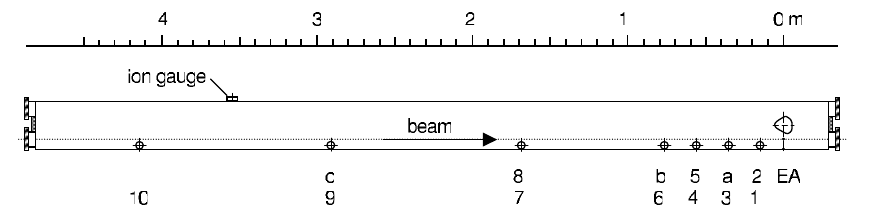
FIG. 1. Modified vacuum chamber (top view) showing locations of RFA detectors 1–10 and BPMs a , b , and c . The top numbers and letters indicate those detectors or BPMs mounted above the chamber midplane; the bottom numbers indicate those mounted below. The end absorber EA intercepts high-energy photons.